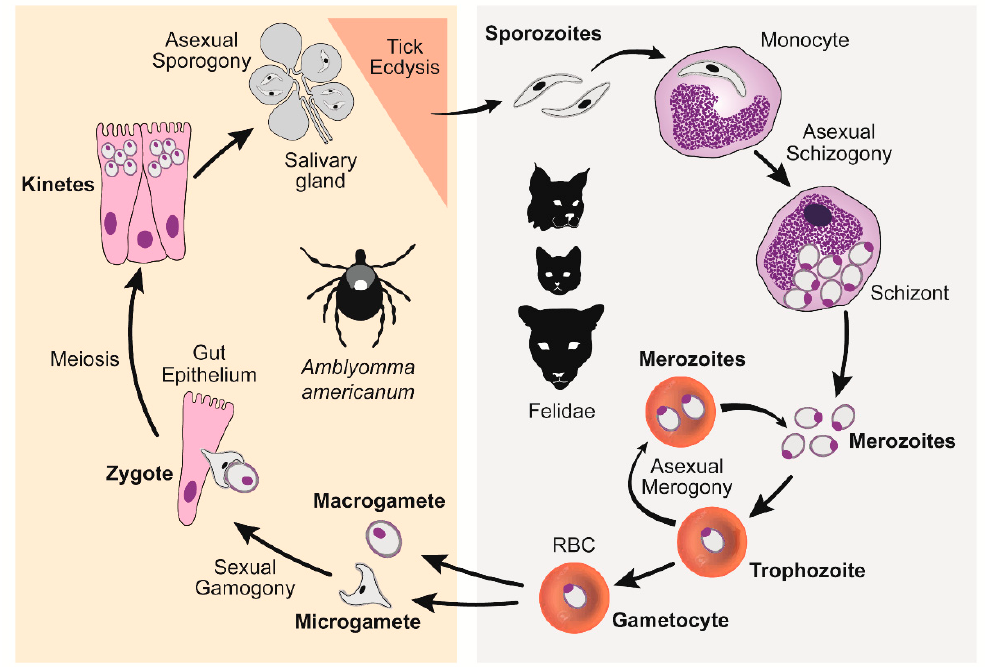
Figure 1. C. felis lifecycle. Right panel: C. felis reproduction within a felid host, asexual schizogony and merogony. Left panel: C. felis reproduction within a tick vector, sexual gamogony and asexual sporogony [10]. (Reproduced with permission from Yvonne Wikander, Pathogens; published by MDPI, 2020.).